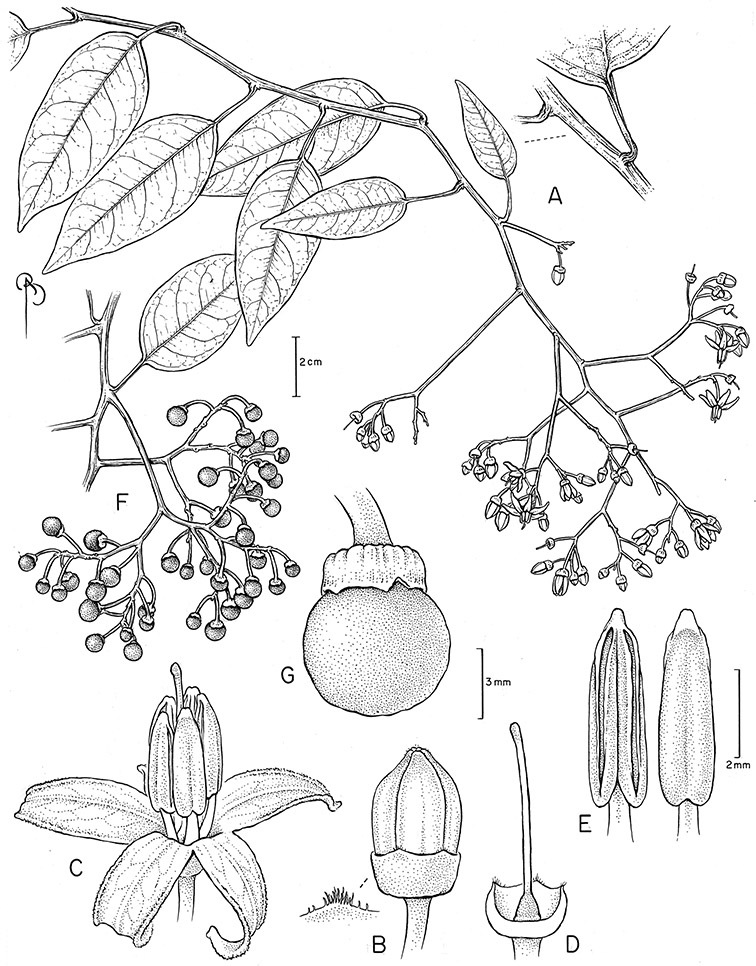
Solanum odoriferum Vell. (A–E drawn from Hatschbach 20204
F–G drawn from Reitz & Klein 6343). Illustration by Bobbi Angell.